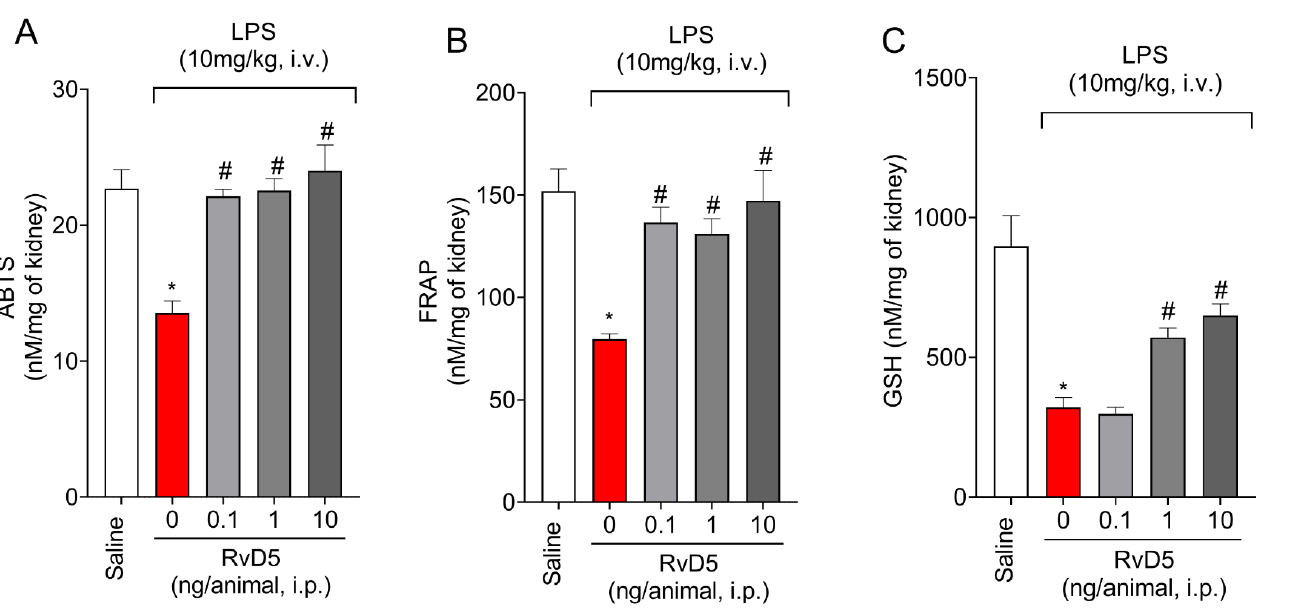
Figure 3. RvD5 reduced LPS endotoxemia-triggered production of IL-1β, TNF-α and IL-6 without affecting IL-10 levels in the kidneys. IL-1β ( A ), TNF-α ( B ), IL-6 ( C ) and IL-10 ( D ) levels were deter- mined in kidney homogenates. Results are presented as mean ± SEM of six animals per group and are representative of two replicates. (* p < 0.05 vs. saline, # p < 0.05 vs. LPS 10 mg/kg; one-way ANOVA followed by Tukey’s post-test .